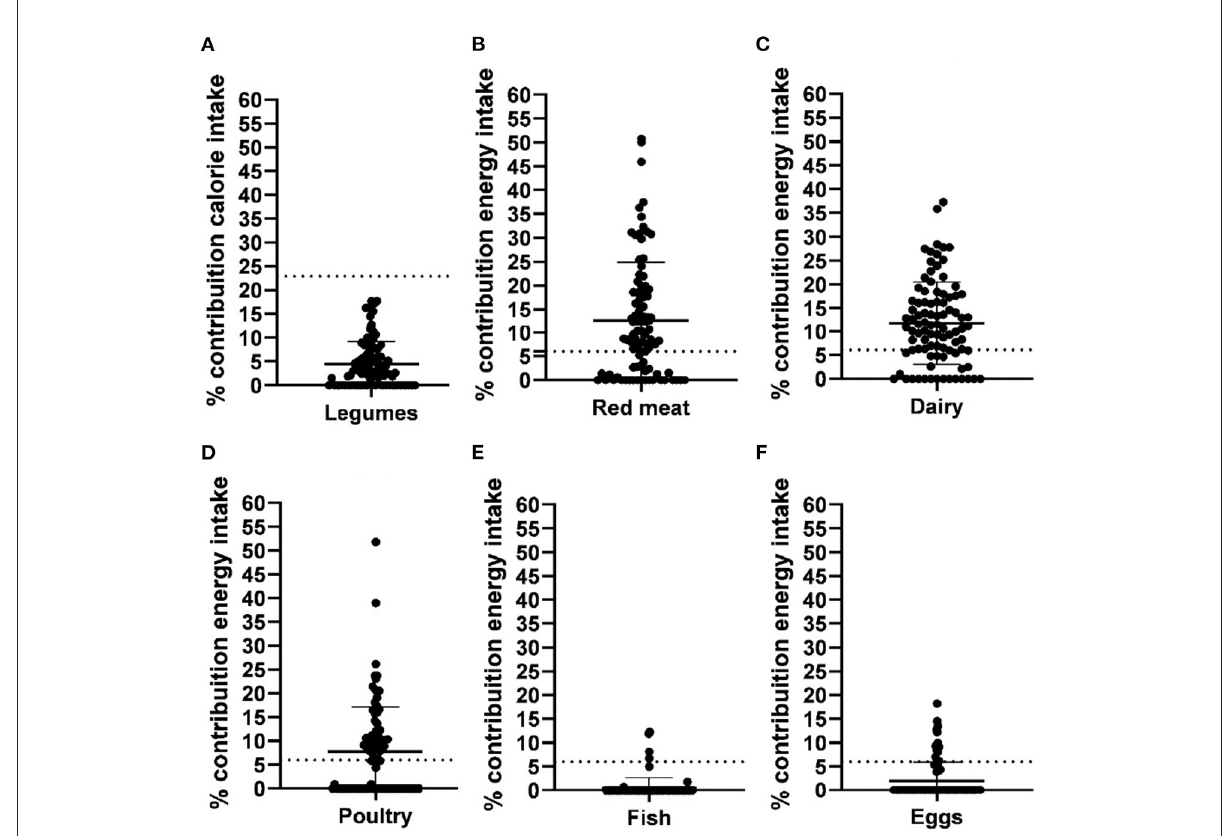
FIGURE3 Comparison of the percentage contribution of energy intake by protein food groups of adolescent athletes compared to percentage % contribution of energy intake by protein food groups of the EAT- Lancet reference diet. Y axis: percentage contribution of energy intake from the food group; Dotted lines: EAT- Lancet reference diet for food group. Legumes and nuts (A) ; Red meat (B) ; Dairy (C) ; Poultry (D) ; Fish (E) ; Eggs (F)